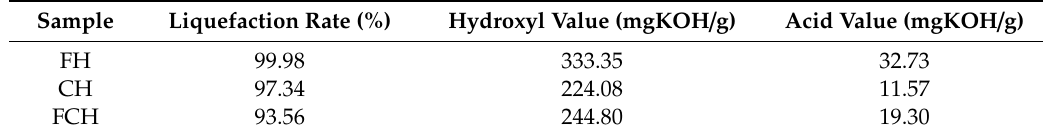
Table 3. Physical properties of FH, CH and FCH.